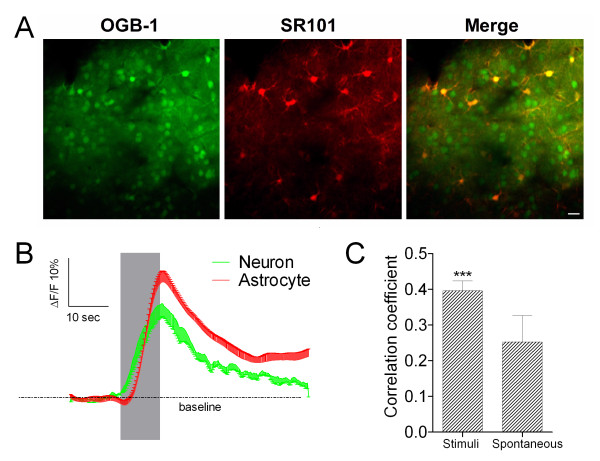
Whisker tactile inputs induce intracellular Ca2+ changes in the neurons and astrocytes of mouse barre cortex. A) shows two-photon images of these nerve cells (200 μm in the depth of barrel cortex), in which OGB-1 labels nerve cells (left panel), SR101 labels astrocytes (middle), and astrocytes are yellow in a merged image (right). Scale bar is 20 μm. B) shows the relative changes of OGB-1 fluorescence signals (ΔF/F) averaged from the cell bodies of neurons (green line) and astroctyes (red) in a barrel network (gray bars are the durations of whisker stimuli). C) illustrates a comparison of neuron-astrocyte pairswise synchrony under the conditions with (n = 8) and without stimuli (n = 6). The synchrony of stimulus-driven activities is significantly higher than that of spontaneous ones (p < 0.01). The synchrony of cellular activities is quantified by using the peak cross-correlation coefficient.